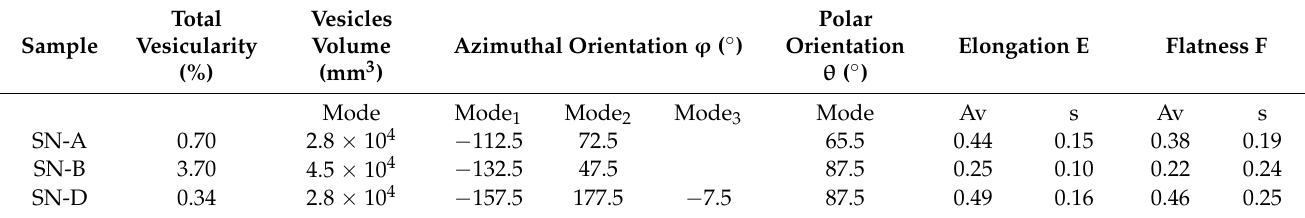
Figure 5. 3D renderings obtained from X-ray microtomography analysis. ( a ) Sample SN-A. Volume rendering of vesicles (left) and bulk sample (right). The natural breakage surface, on which the microanalysis and microscopic observation were carried out, is also indicated; ( b ) sample SN-B. Inte- grated volume rendering of vesicles and bulk sample. The natural breakage surface is also indicated. Note the arrangement of vesicles in bands oriented at c. 45° with respect to the external surface; ( c ) sample SN-D. Volume rendering of vesicles (left) and of bulk sample (center) and macroscopic view of the sample used for X-ray microtomography. Dots with the same color indicate the same point on the three images (red dots: highly vesiculated band, light green in the macroscopic sample; blue dots: poorly vesiculated band, dark green in the macroscopic sample). In all the figures the reference system used to calculate azimuthal ( ϕ ) and polar ( θ ) directions is shown. The two angles are illustrated in the inset. Table 2. Volume, orientation and shape parameters of